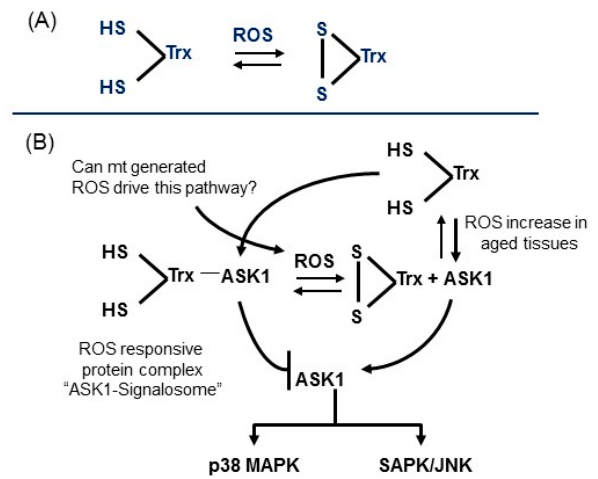
Figure 2. Thioredoxin links the production of ROS to the activation of stress response pathways. ( A ) Thioredoxin plays a major role in the regulation of the redox state of the cell. ( B ) The redox state of thioredoxin plays a key role in the regulation of the ASK1 → P38 MAPK and SAPK / JNK stress response signaling pathways.